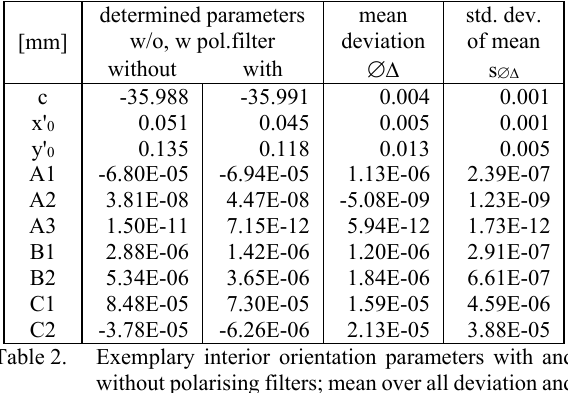
Exemplary interior orientation parameters with and without polarising filters; mean over all deviation and its standard deviation.